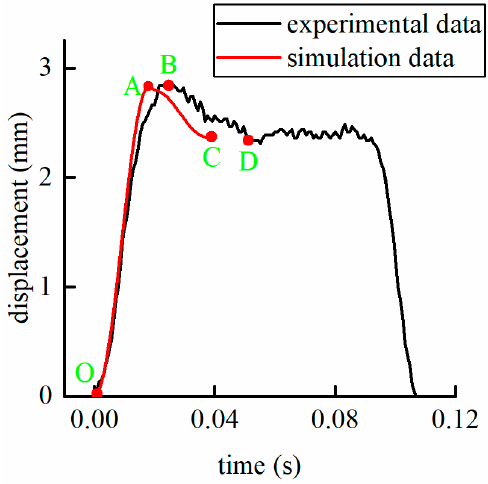
Figure 5. Movement curve of actuator with small hydraulic pressure.